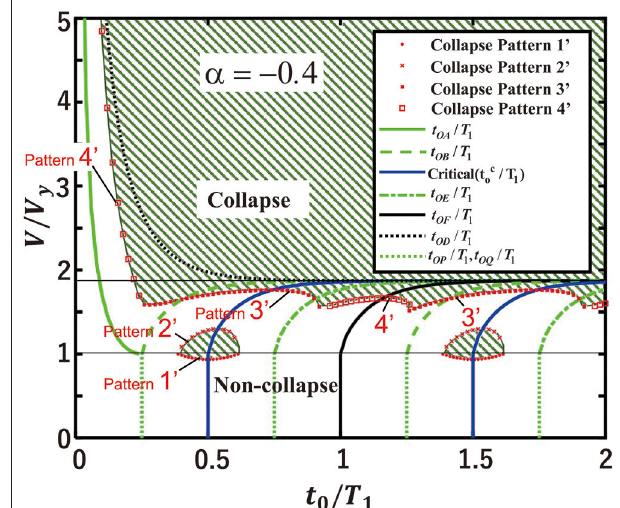
FIGURE 11 | Second impulse timing t 0 / T 1 -input velocity relation for collapse and non-collapse states ( α 0.4). = −